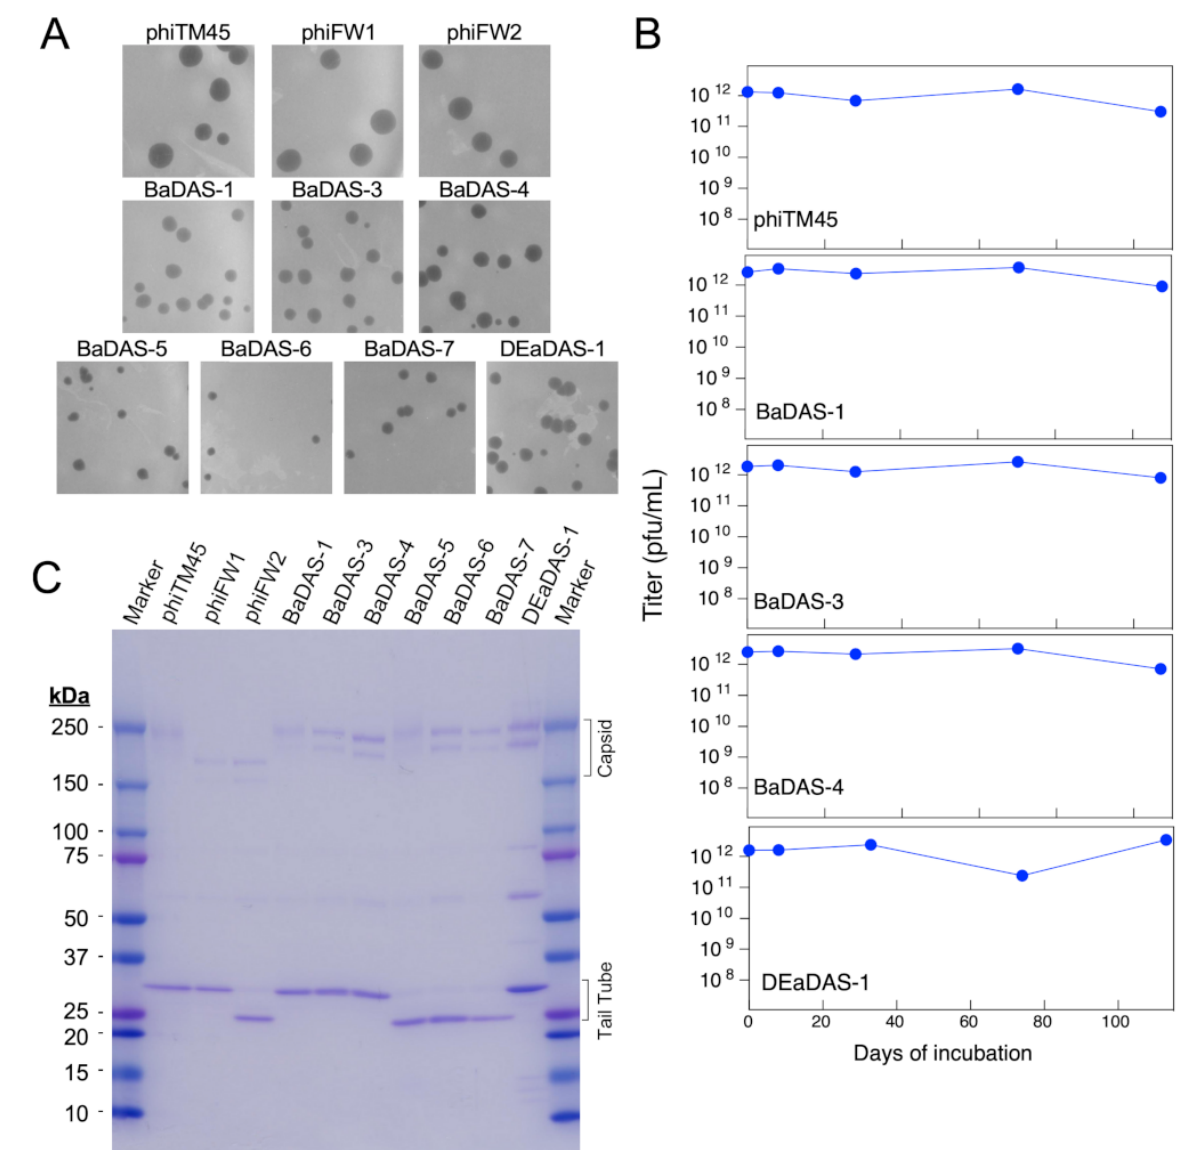
Figure 4. Characterization of BaDAS and DEaDAS recombinant phages. ( A ) phiTM45 and derivatives phiFW1 and phiFW2 form large plaques on M. smegmatis , whereas all other derivatives form somewhat smaller plaques. ( B ) Thermostability of high titer, highly purified preparations of phiTM45 and vaccine candidates were assessed by determining the titer after incubation at ~4 ◦ C for different times. All phages were stable for ~100 days of simple refrigeration. ( C ) SDS-PAGE of virion proteins shows the impact of modifications of capsid and tail tube